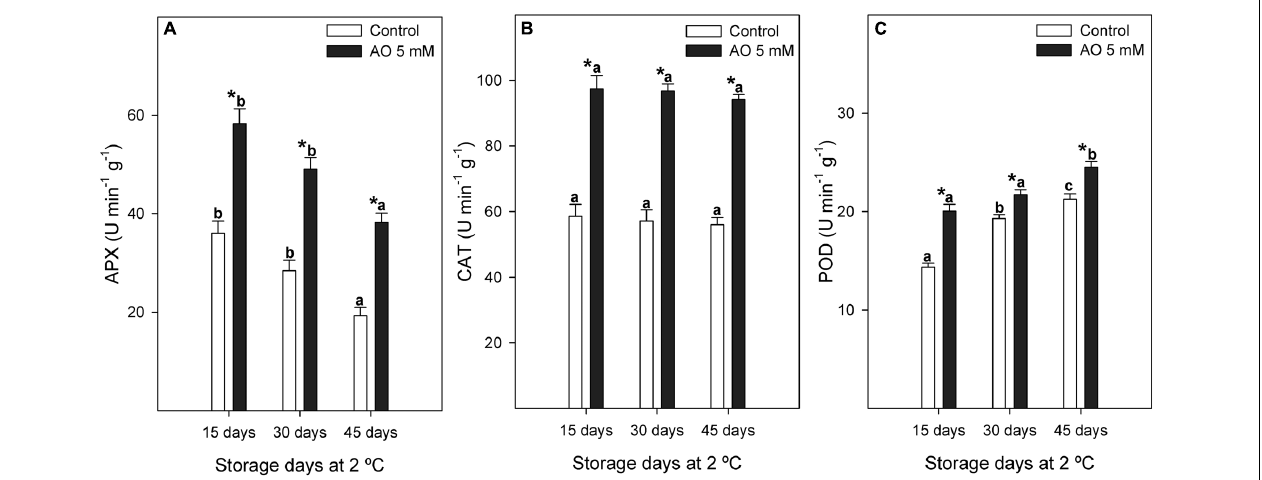
FIGURE 5 | Evolution of ascorbate peroxidase [APX (A) ], catalase [CAT (B) ], and peroxidase [POD (C) ] activities (U min − 1 g − 1 ) measured in control and 5 mM oxalic acid (OA)-treated ‘Magenta’ table grapes during 15, 30, and 45 days of postharvest storage at 2 ◦ C. Data are the mean ± SE. Significant differences ( p < 0.05 according to Student’s t -test) between control and OA-treated berries were expressed as * symbol placed in the OA bar for each storage day and antioxidant enzyme. Different lowercase letters show significant differences ( p < 0.05 according to HSD Duncan’s test) among the three storage days in